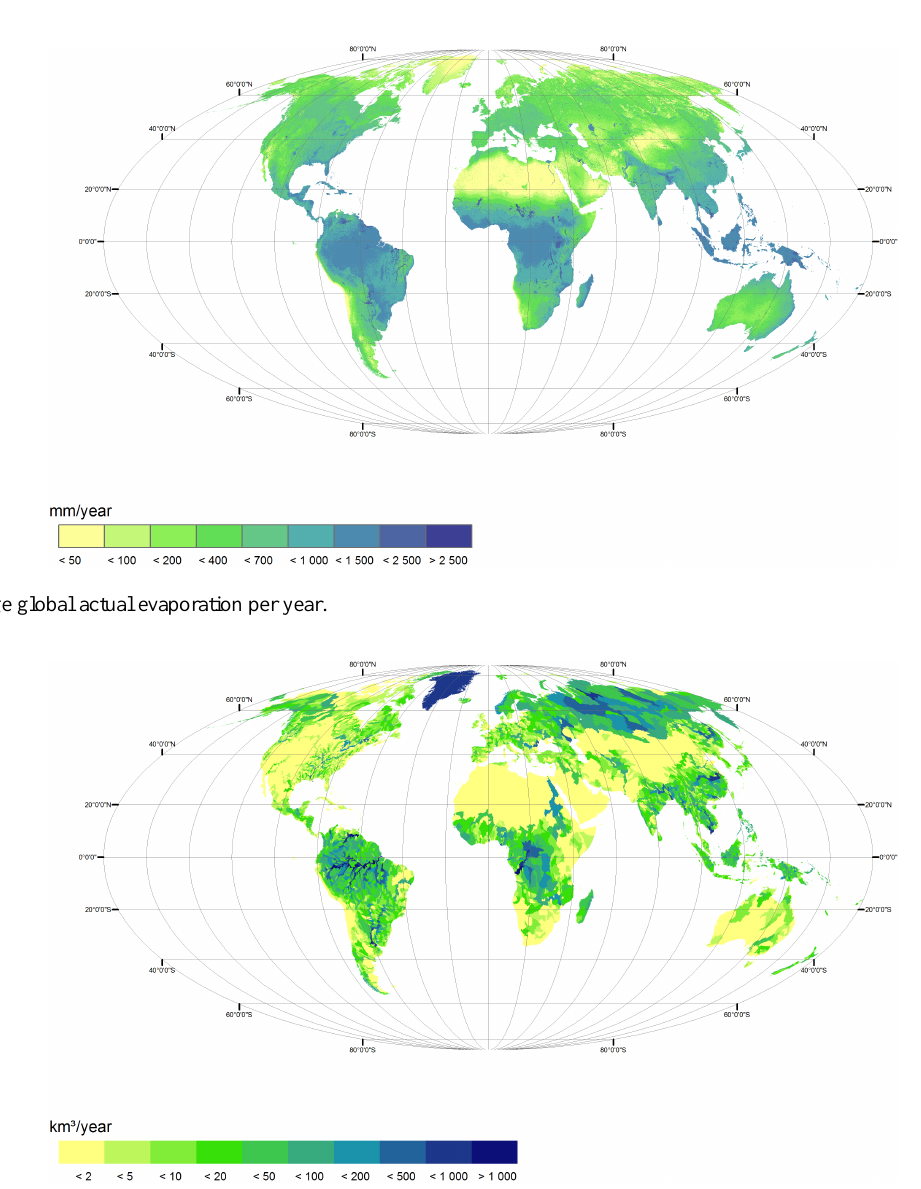
Figure 4. Average annual outflow per